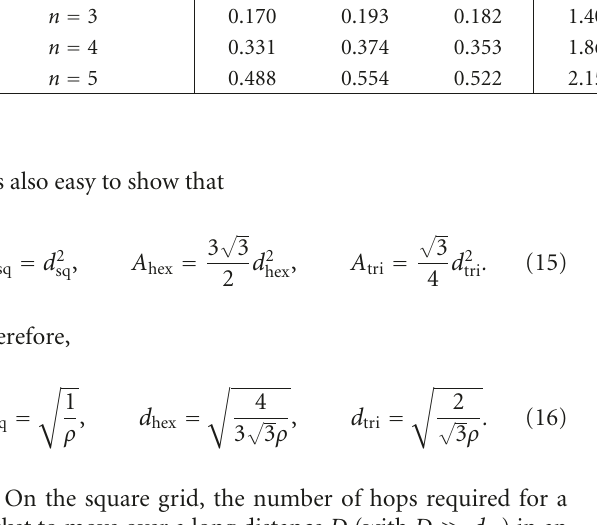
Table 4: Comparison of the network throughput in bits-meters/s/Hz/node under ρ = 1. , α ∗ α ∗ SAM,sq , α ∗ SAM,hex